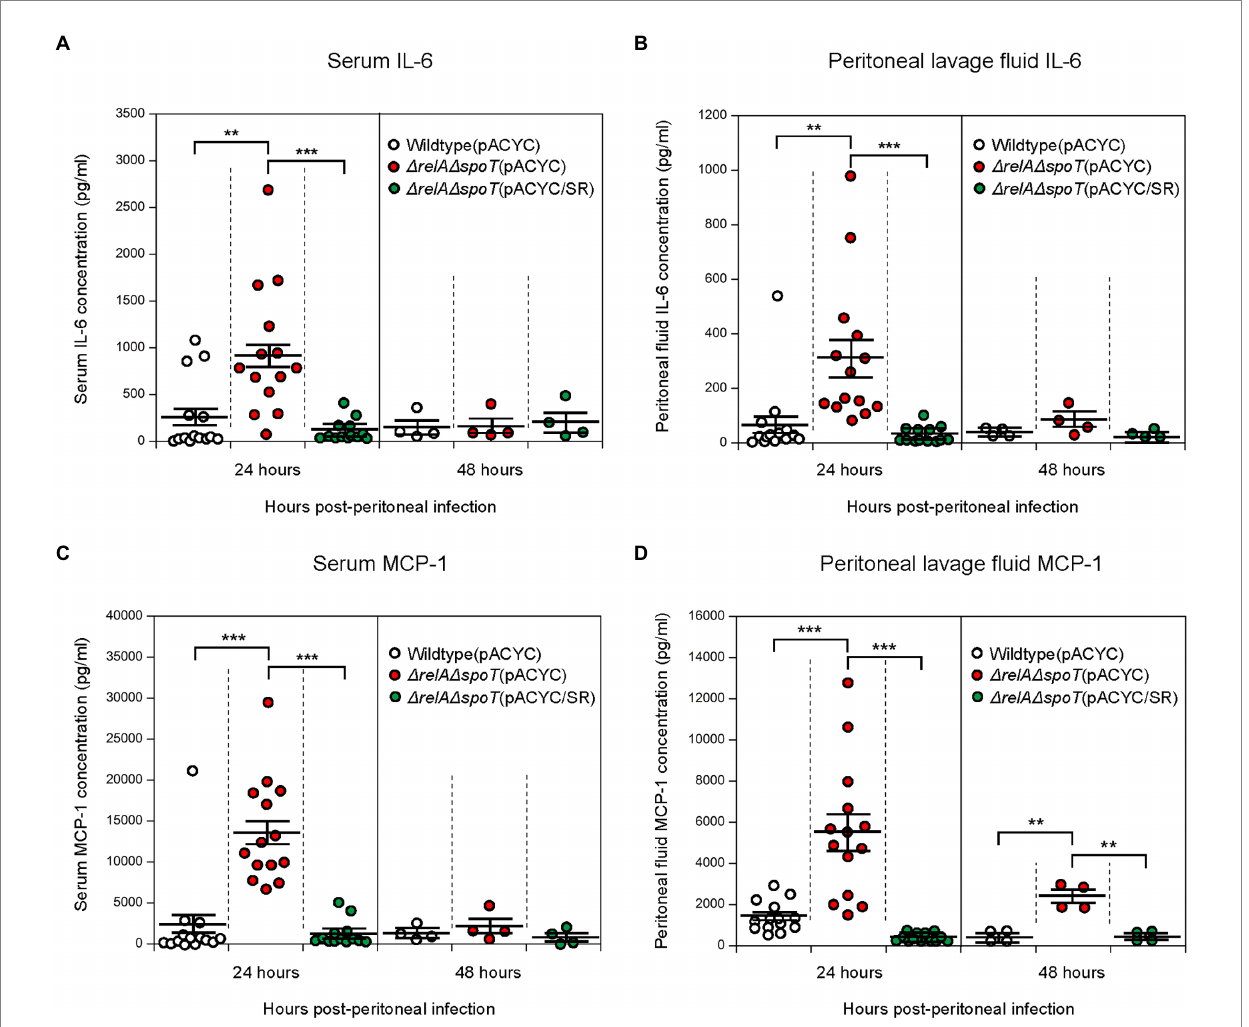
FIGURE 7 Increased expression of interleukin-6 (IL-6) and monocyte chemoattractant protein-1 (MCP-1) in C57BL/6 mice infected with Δ relA Δ spoT EPEC. C57BL/6 mice were challenged with wildtype (white), Δ relA Δ spoT mutant (red), or relA- and spoT -complemented mutant strain (green) via peritoneal injection. Samples were collected at 24 and 48 h post infection. (A,B) IL-6 concentration was quantified by enzyme-linked immunosorbent assay (ELISA) for blood serum (A) and lavage fluid (B) samples. Wildtype (pACYC), E2348/69 strain carrying pACYC184; Δ relA Δ spoT (pACYC), E2348/69 Δ relA Δ spoT mutant carrying pACYC184; Δ relA Δ spoT (pACYC/SR), E2348/69 Δ relA Δ spoT mutant carrying pACYC/SR. (C,D) MCP-1 concentration was also quantified by ELISA for serum (C) and lavage fluid (D) samples. Circles represent individual mice. Horizontal bars represent means ± standard errors of means. Statistical significance was obtained by Student’s t -test (** p < 0.01; *** p <